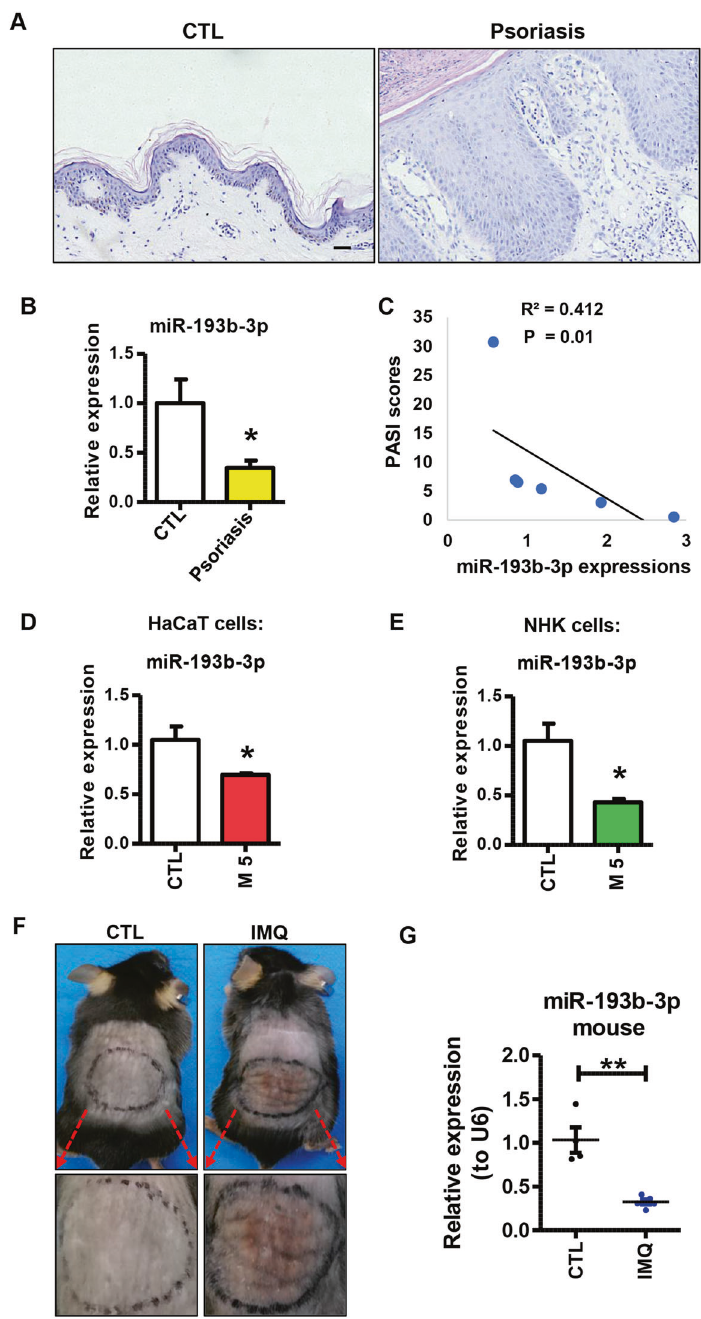
Fig. 1 miR-193b-3p is downregulated in psoriasis patients and M5-induced keratinocytes. A Representative images showing the pathological morphology of skin tissues derived from psoriasis patients and healthy donors using H&E staining. Scale bar: 50 µm. B Expression levels of miR-193b-3p in skin tissues derived from healthy donor (CTL, n = 5) and psoriasis patient (Psoriasis, n = 6). mRNA levels were analyzed using quantitative real-time PCR (qRT-PCR). U6 was used as the internal control. Each bar represents mean ± SEM. * P < 0.05, compared with the indicated controls. C Correlation of miR-193b-3p expression with the PASI score of corresponding patients ( n = 6). D Expression levels of miR-193b-3p in HaCaT cells in the presence or absence of M5 treatment. mRNA levels were analyzed using qRT-PCR. U6 was used as the internal control. Each bar represents mean ± SEM ( n = 4). * P < 0.05, compared with the indicated controls. E Expression levels of miR-193b-3p in normal human keratinocyte cells (NHK cells) in the presence or absence of M5 treatment. mRNA levels were analyzed using qRT-PCR. U6 was used as the internal control. Each bar represents mean ± SEM ( n = 4). * P < 0.05, compared with the indicated controls. F Representative images showing the skin lesions of Vaseline (CTL) and IMQ-treated mice (IMQ). G Expression levels of miR-193b-3p in the back skin of Vaseline (CTL) and IMQ-treated mice (IMQ). mRNA levels were analyzed using qRT-PCR. U6 was used as the internal control. Each bar represents mean ± SEM ( n ≥ 4). ** P < 0.01, compared with the indicated